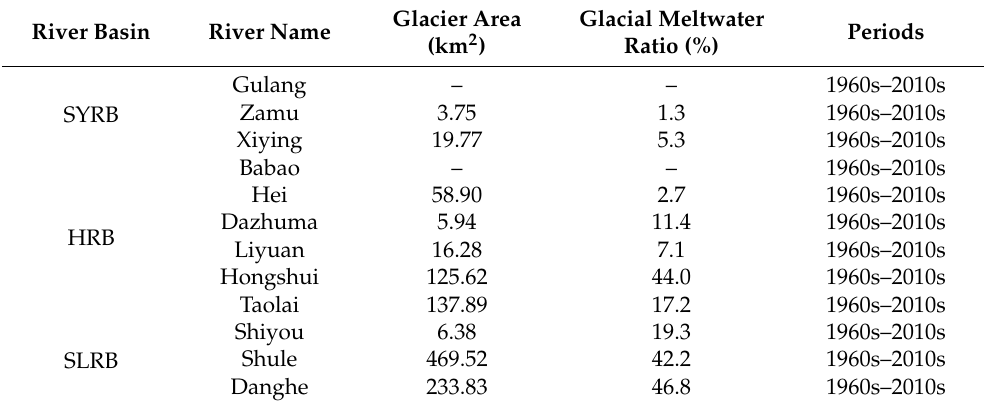
Table 5. Glacier area and percentage of glacier meltwater runoff in this study [25,54]. River Basin River